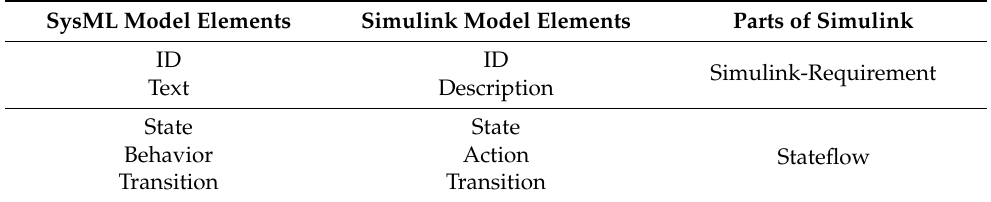
Table 4. The mapping relationship between SysML and Simulink